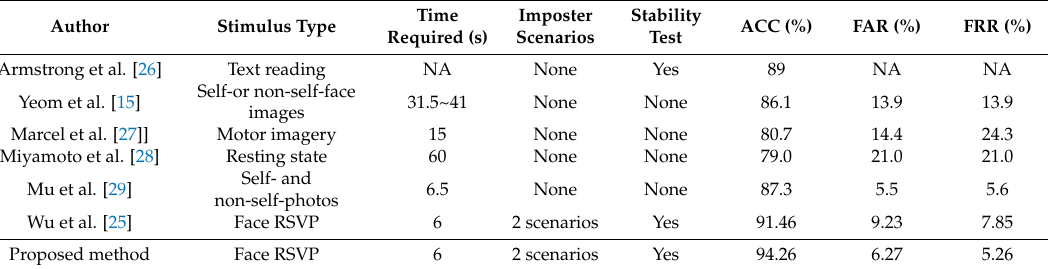
Table 4. Performance comparison with previous related